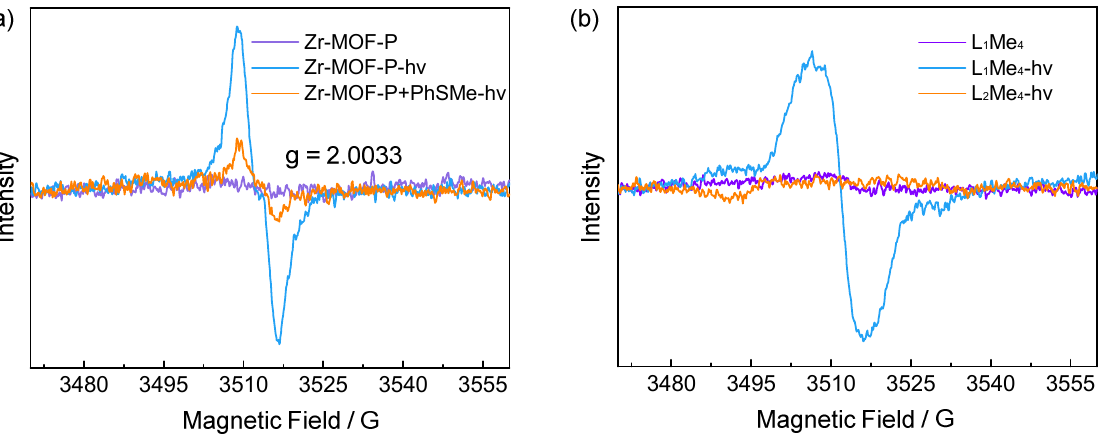
Figure 6. ( a ) EPR spectra of Zr-MOF-P under different conditions. ( b ) EPR spectra of L 1 Me 4 and L 2 Me 4 under different conditions.